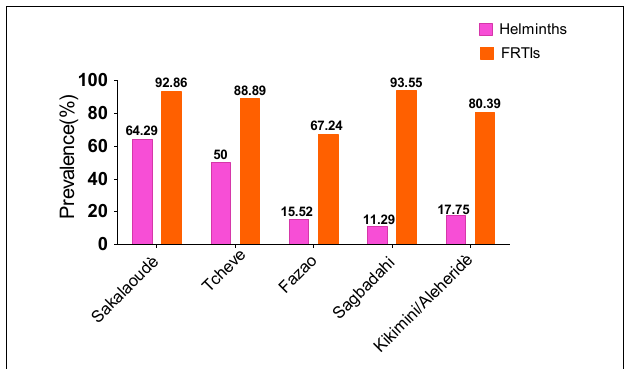
FIGURE 4 | Prevalence of helminthiasis and FRTIs by village. The pink bars present the prevalence of helminthiasis, and the orange bars present the prevalence of FRTIs.